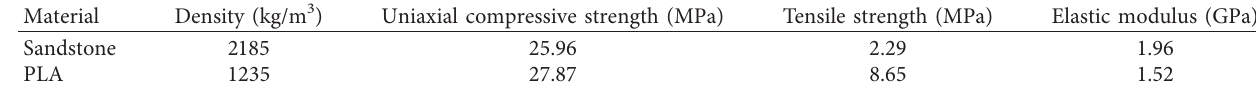
Figure 1: (a) Schematic diagram of the geometric parameters of preexisting joint and excavation area. (b) Experimental samples. Table 1: Physical and mechanical properties of sandstone and PLA material.